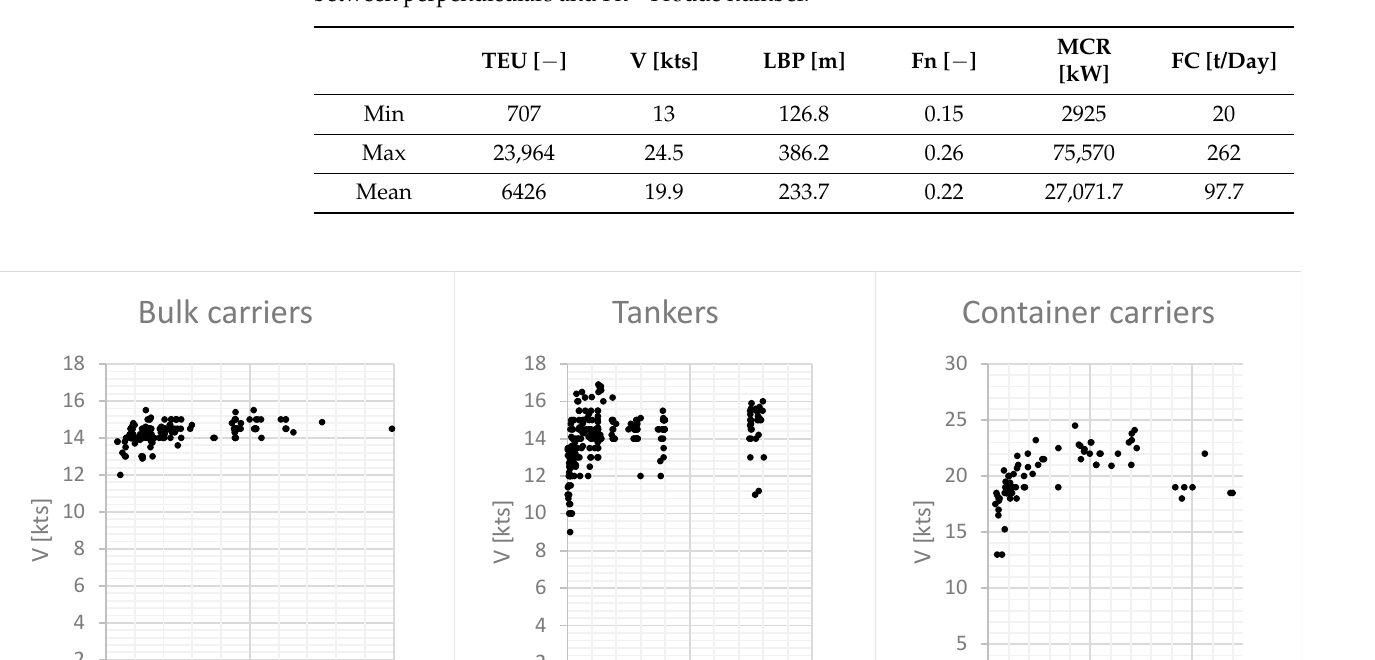
Table 3. Mean, minimum and maximum container ship parameter values, where: MCR—total engine power, FC—daily fuel consumption, TEU—number of TEU containers, V—speed, LBP—length between perpendiculars and Fn—Froude number.